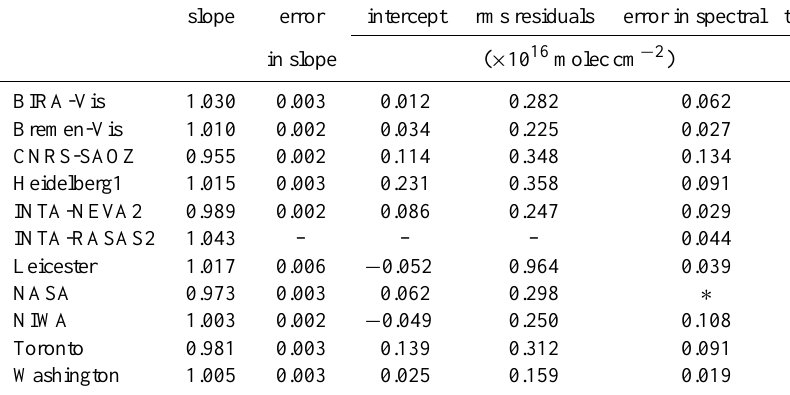
Table 4. Statistics of results from the intercomparison of zenith-sky measurements of slant columns of NO 2 at twilight. INTA-RASAS2 is the reference, so its errors, intercepts and residuals have no meaning, and its slope is that of the mean of the whole group that defines the normalisation. slope